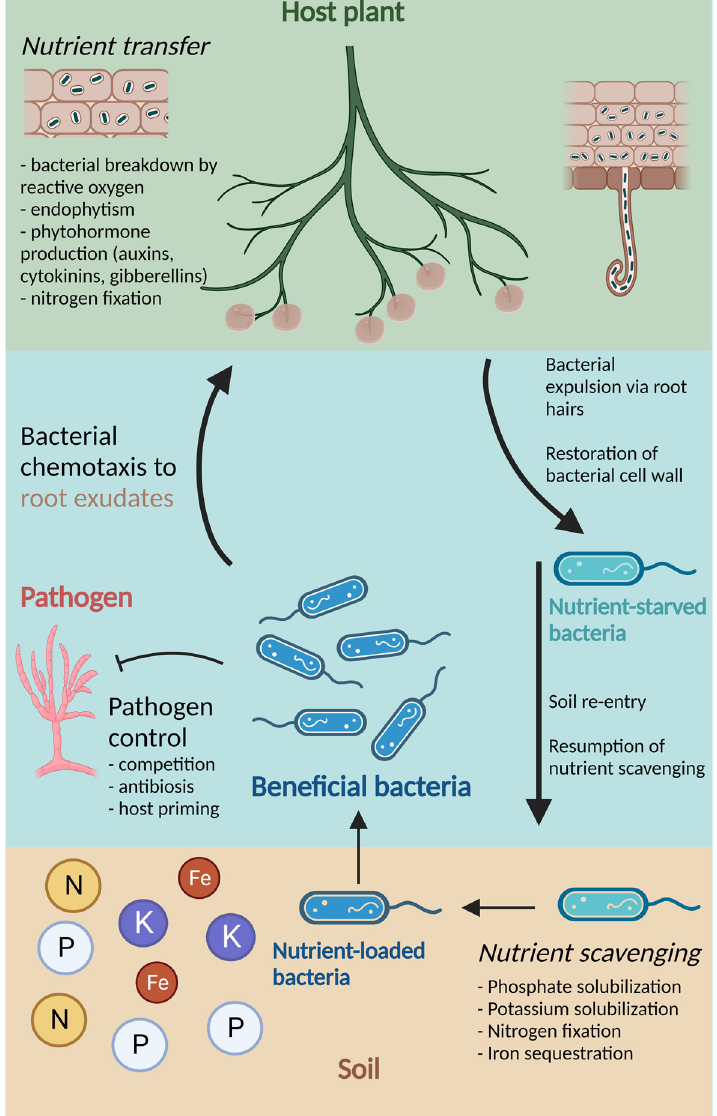
Figure 1 . Schematic representation of the growth-promotional and defensive functions provided by beneficial bacteria, including participation in the rhizophagy cycle. The host plant (labeled in green) breaks down soil bacteria with ROS, allowing for endophytism and transfer of nutrients and phytohormones. Following this, nutrient-starved bacteria are expelled via root hairs, where they can restore their cell walls. In soil, bacteria resume nutrient scavenging, which includes phosphate and potassium solubilization, nitrogen fixation, and iron sequestration. Nutrient-loaded bacteria (labeled in blue) are subsequently attracted back to the host plant via root exudates, where they are degraded by ROS and nutrient transfer can occur again. Throughout this cycle, beneficial bacteria may also participate in pathogen control through competition, antibiosis, and priming of the host plant’s resistance. Created with BioRender.com.